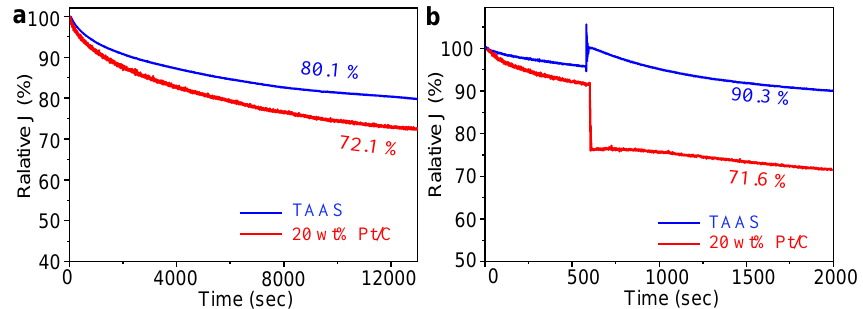
Figure 6. The stability curve of TAAS and 20 wt% Pt/C in O 2 -saturated 0.1 M KOH solution, RDE rotation rate of 1600 rpm, 15,000 s stability curve ( a ) and the methanol tolerance performance curve measured by current-time chronoamperometry ( b ).